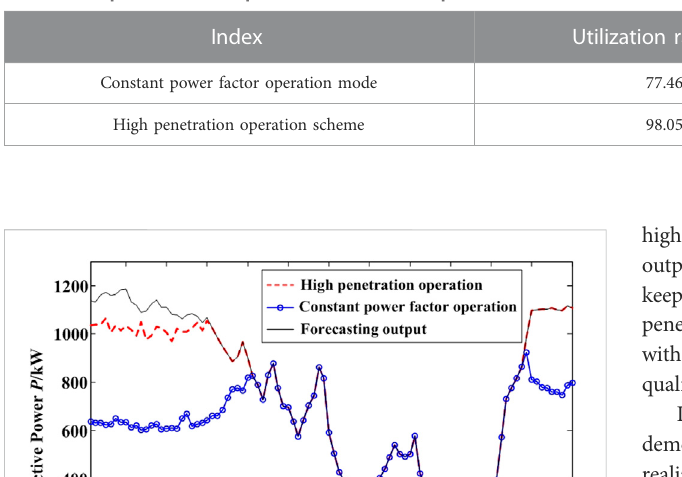
TABLE 2 Comparison on two operation modes of wind power.